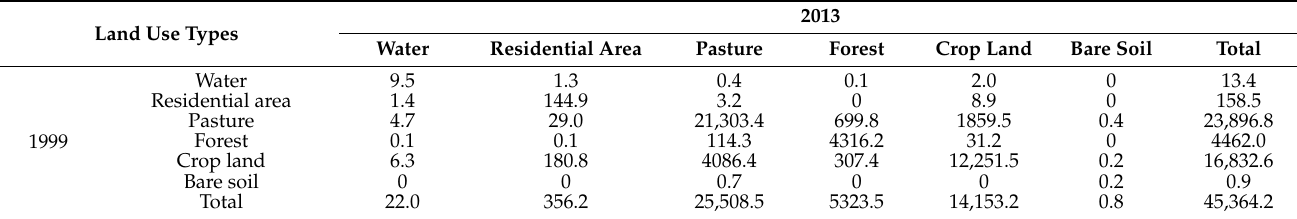
Table 4. LUCC transfer matrix of the JRB from 1999 to 2013 (area:km 2